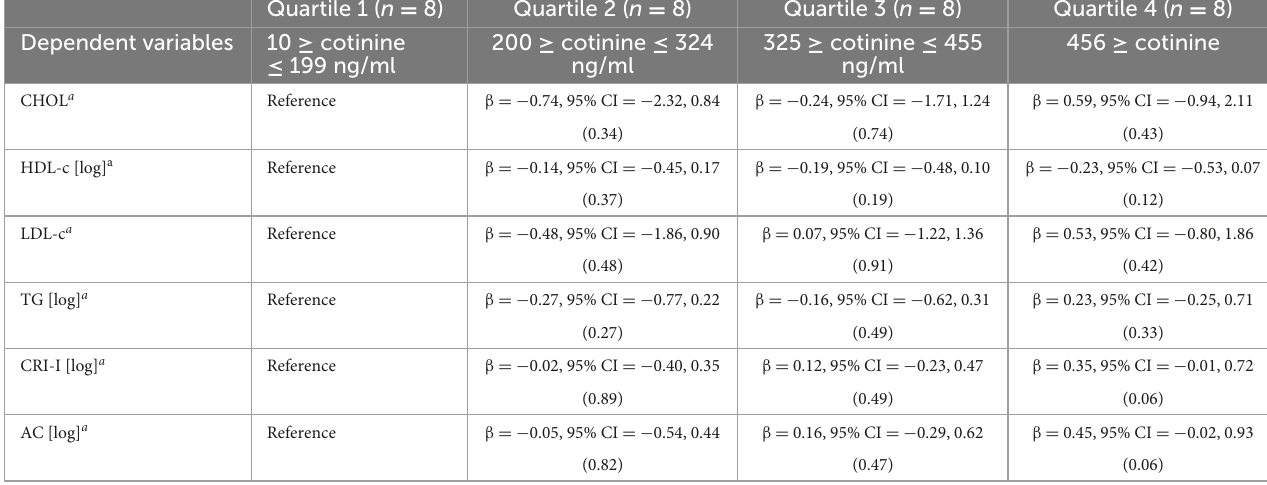
TABLE 3 The associations of quartile of serum cotinine level (Reference: 10 ≥ cotinine ≤ 199 ng/ml) with lipid-related indices a